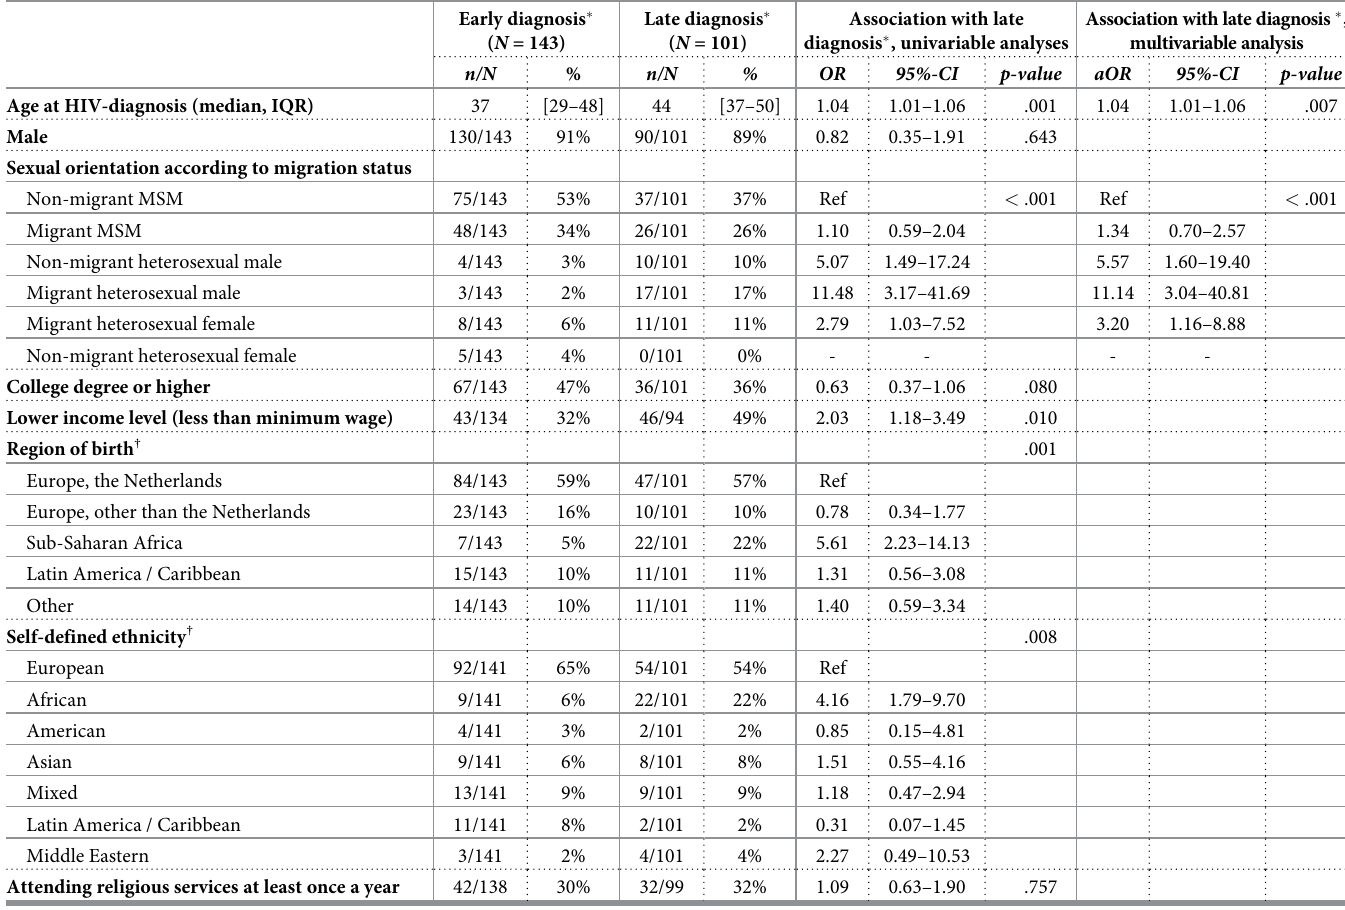
Table 1. Socio-demographic characteristics of aMASE-study participants in the Netherlands, 2013–2015, including uni- and multivariable logistic regression analy- sis of determinants associated with late diagnosis of HIV infection.